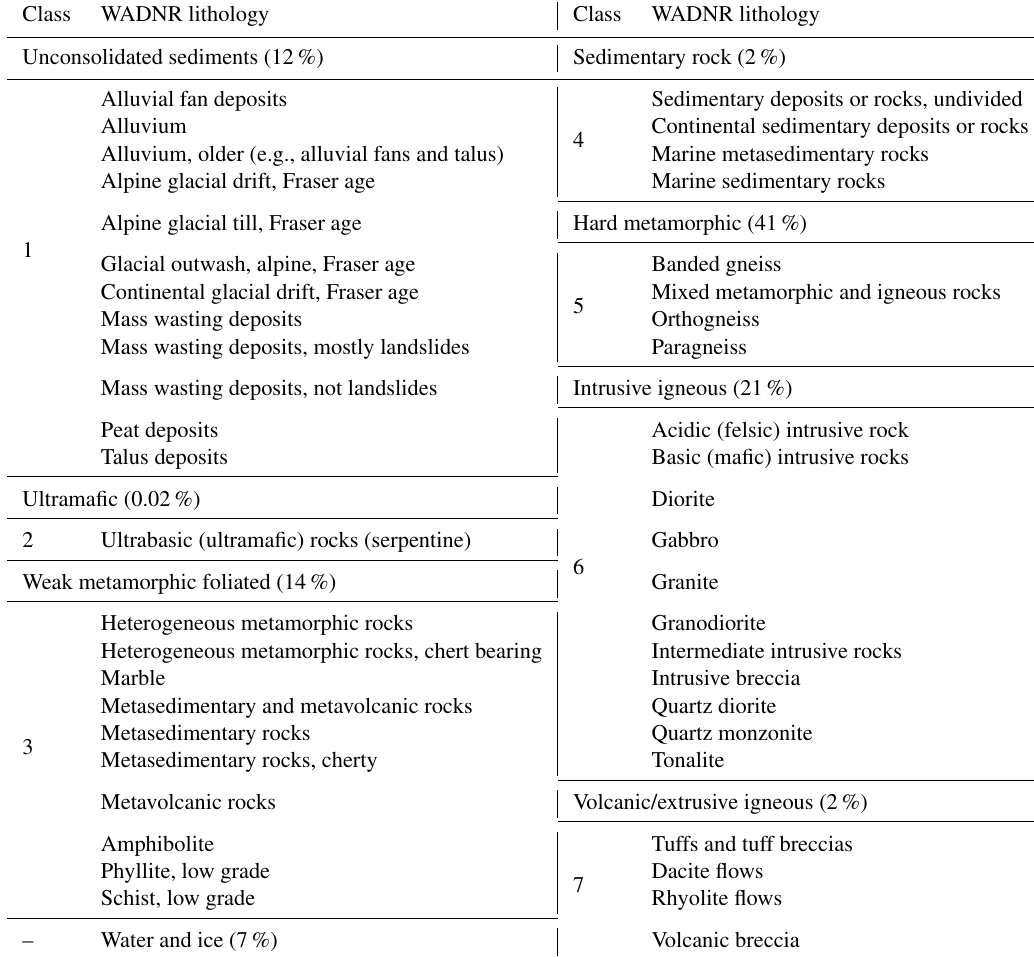
Table 3. Classification from the Washington Department of Natural Resources of surface geology from generally weaker (1) to stronger (6) material along with aerial percentages within NOCA in